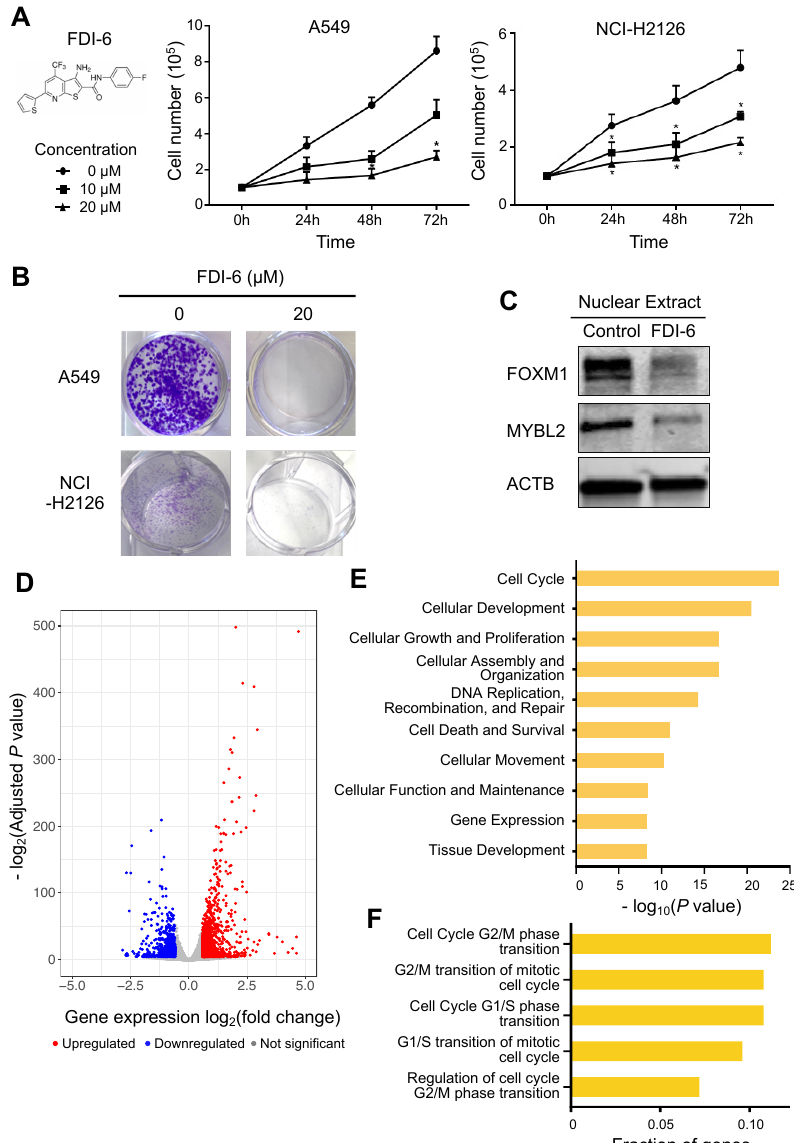
Figure 5. FDI-6 alters cell proliferation and inhibits the activities of FOXM1 and MYBL2 in lung adenocarcinoma cells. ( A ) A structure of FDI-6 ( left ). A549 and NCI-H2126 cells were counted every 24 h after treatment with different concentrations of FDI-6 for 72 h ( n = 3). Data represent the mean SE ( n = 3). Statistical significance was determined using Student’s t -test. *, p -value ≤ 0.05 vs. control. ( B ) Colony formation images of A549 and NCI-H2126. A549 and NCI-H2126 cells after being treated with FDI-6 for 24 h and then incubated for 14 days. ( C ) FOXM1 and MYBL2 protein expression levels were analyzed in the nuclear extract of A549 cells by Western blot ( right ) ( n = 3). ACTB is used as a control. ( D ) A volcano plot demonstrating differential gene expression after treatment of FDI-6 in A549 cells. X -axis shows the log2 fold change between FDI-6 treated and untreated cells, and Y -axis shows the − log2(adjusted p -value) upon the comparison between FDI-6 treated and untreated cells. The red dots represent the upregulated genes, the blue dots represent the downregulated genes, and the gray dots represent the genes that are not statistically significantly differentially expressed ( − log2(adjusted p -value) > 0.05 and fold change < 1.5). ( E ) A barplot showing the top 10 biological functional categories in which FDI-6 target genes (identified by downregulated genes upon FDI-6 treatment with FOXM1-bound promoters) are most enriched. ( F ) Fraction of genes whose expression levels are changed upon FDI-6 treatment and involved in each cell cycle phase are